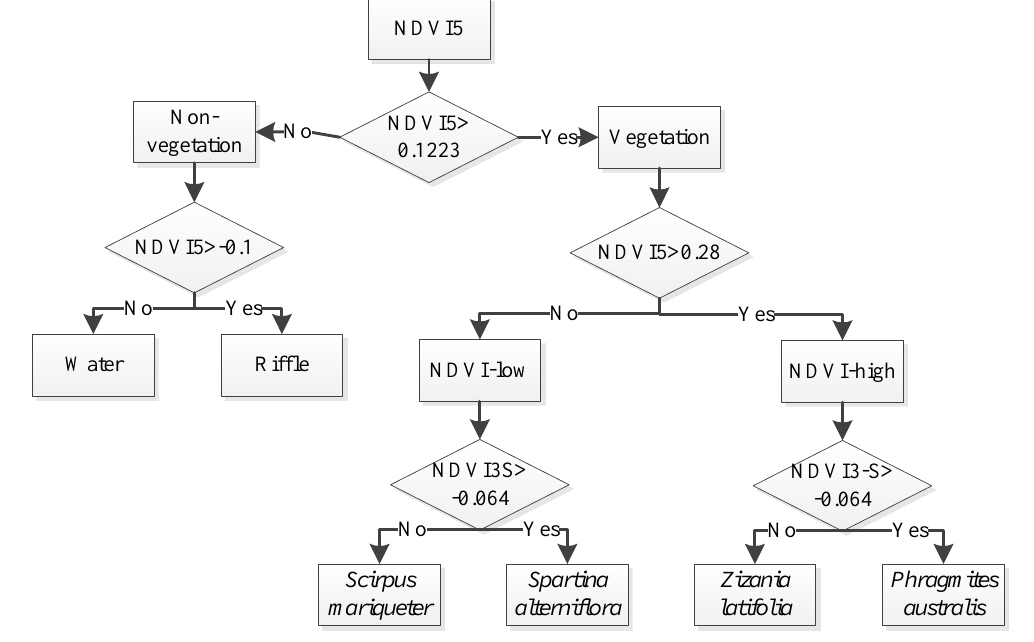
Figure 3. The classification decision tree for dominant plant species. NDVI5: NDVI in May; Non-vegetation: non-vegetated area; Vegetation: vegetated area; NDVI5-low: low NDVI value in May; NDVI5-high: high NDVI value in May; NDVI3-S: NDVI in